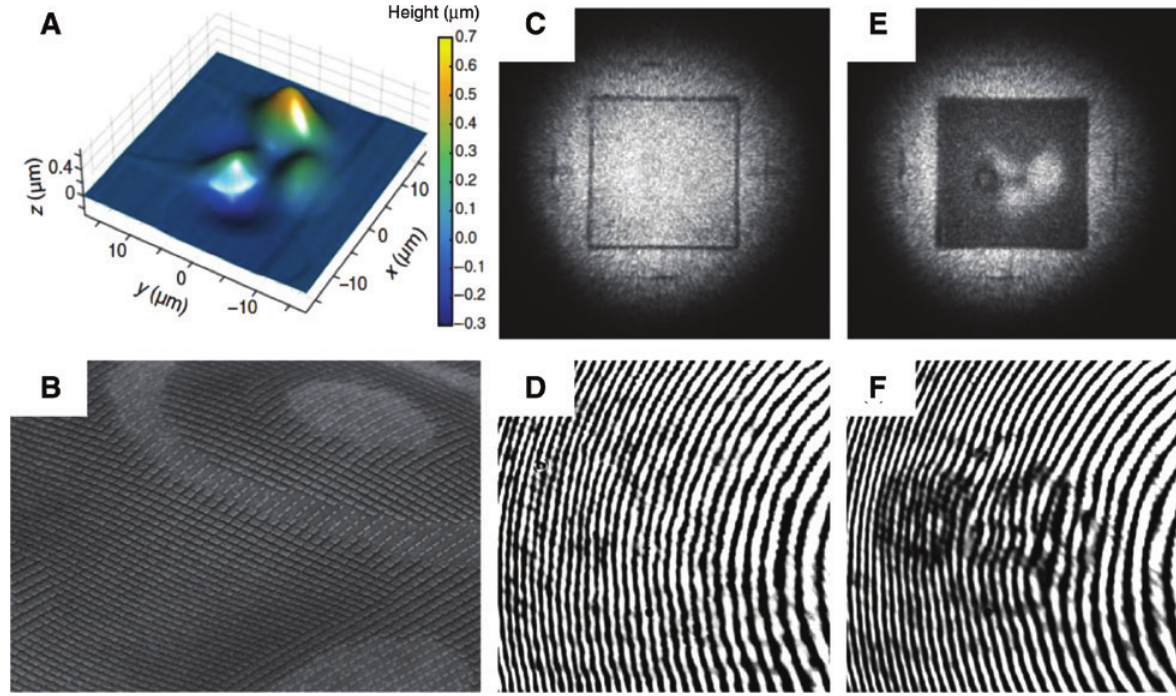
Figure 6: A metasurface invisibility skin cloak for a 3D arbitrarily shaped object.